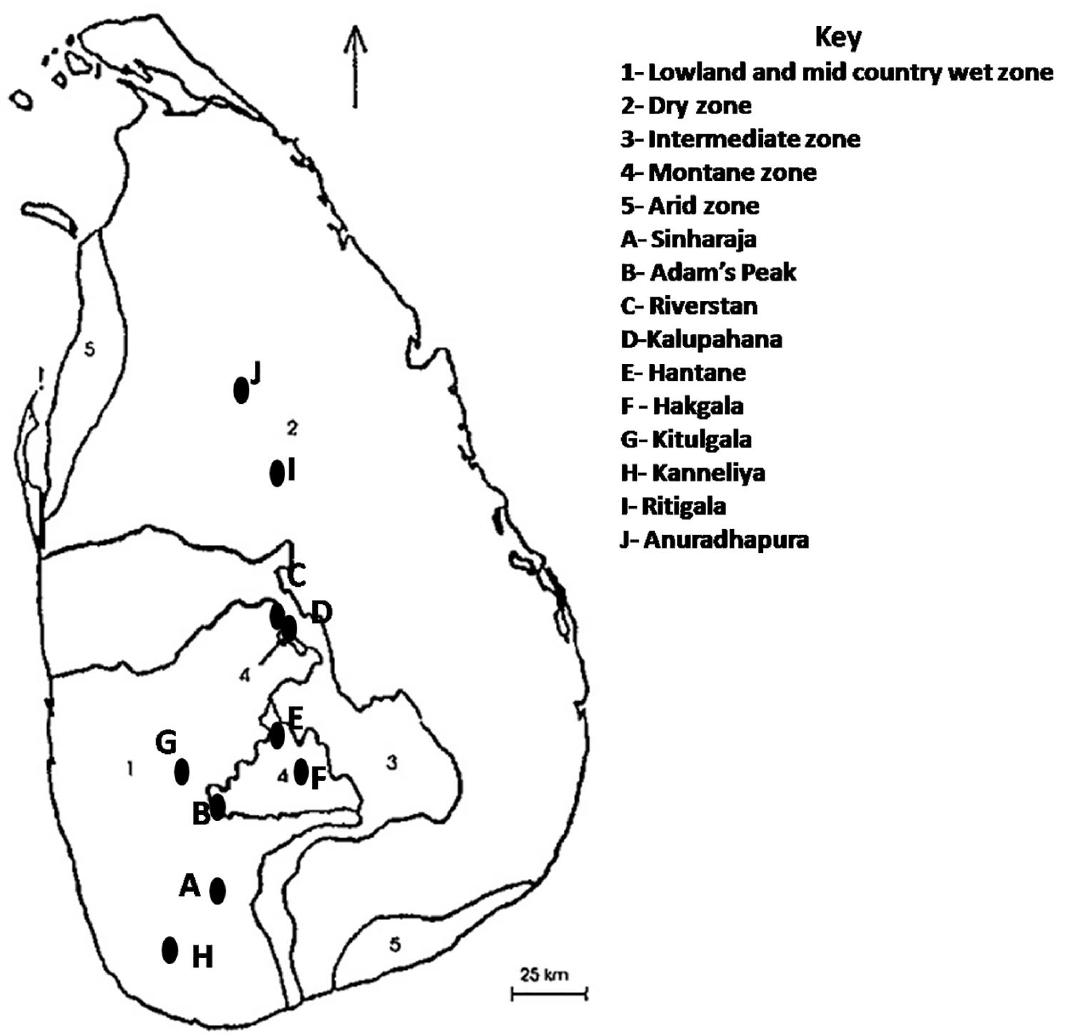
Figure 1 : The map of Sri Lanka showing the locations of the visited sites during the study